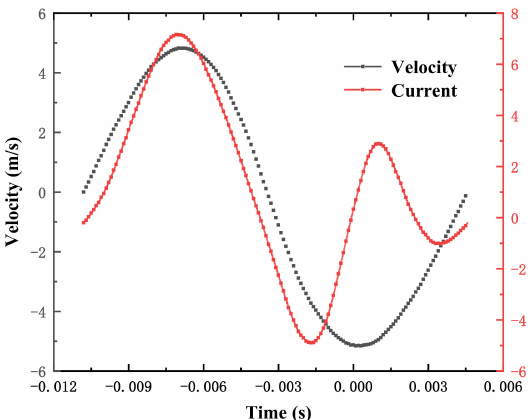
Figure 13. The current and velocity of the SVLC, obtained from the experiment.